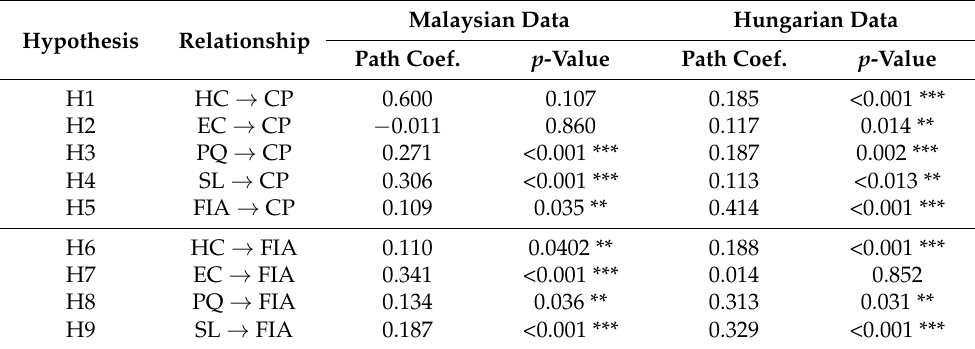
Table 5. Results of hypotheses testing for Malaysia and Hungary. Malaysian Data Hungarian Data Hypothesis Relationship Path Coef. p